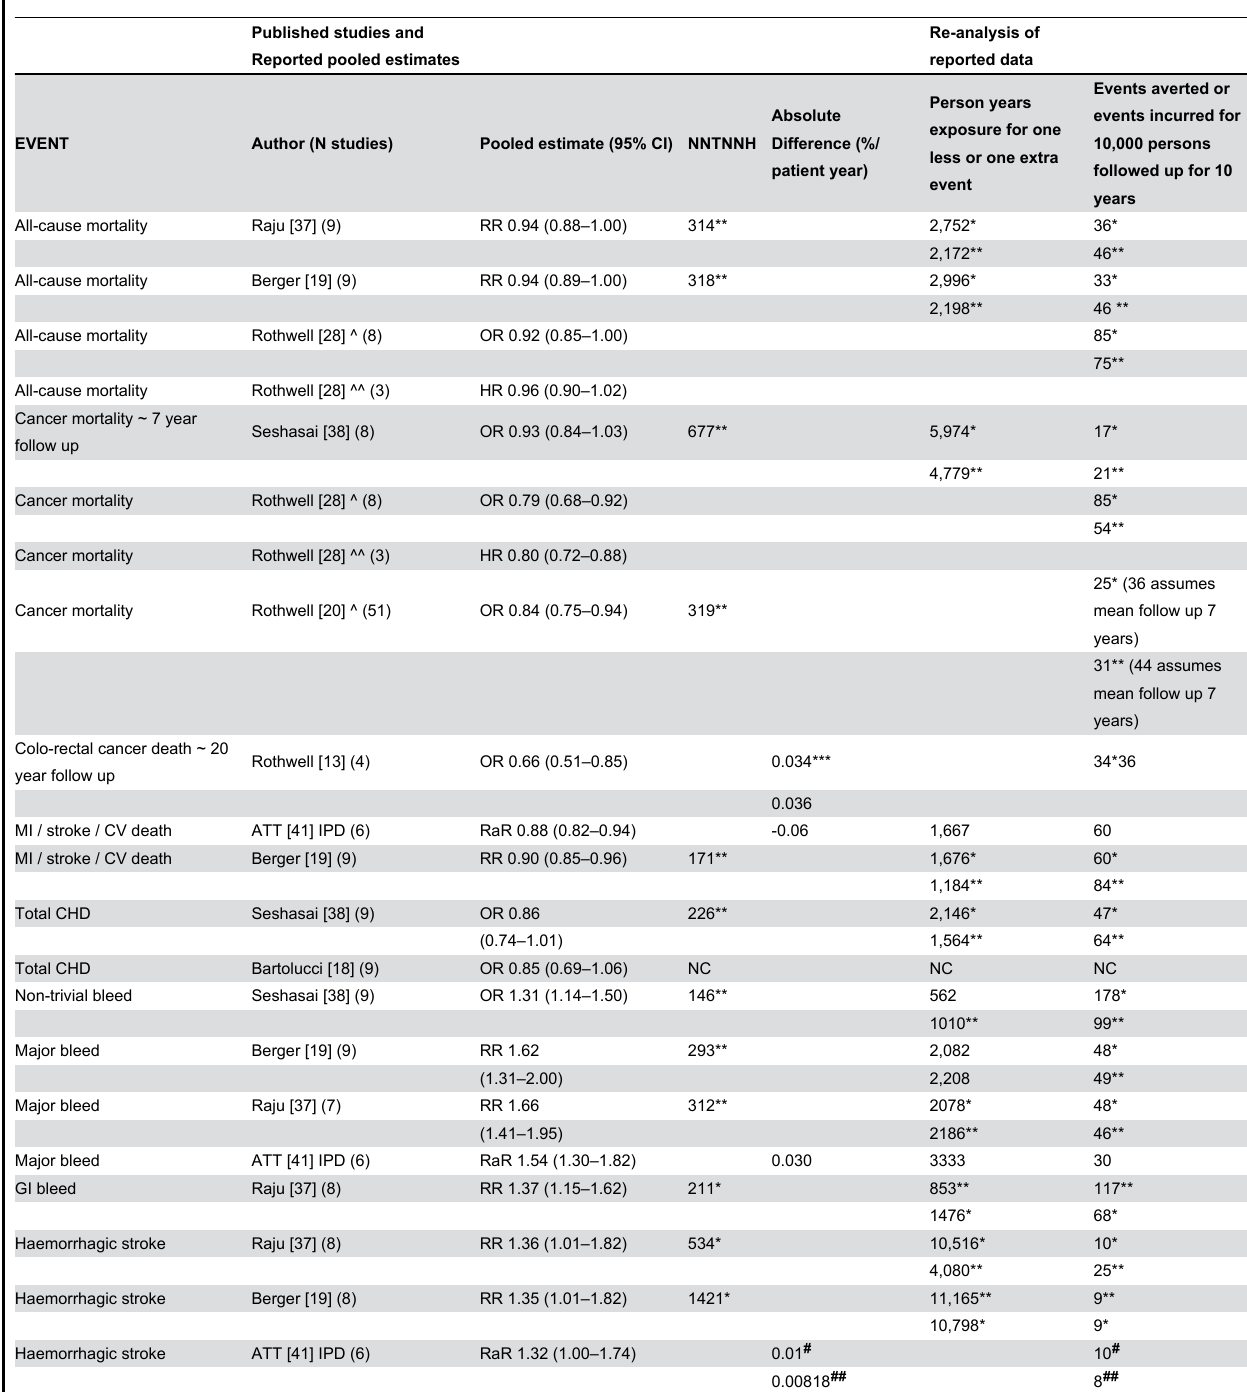
Table 2. Results from CVD and cancer systematic reviews: all comparisons aspirin vs.